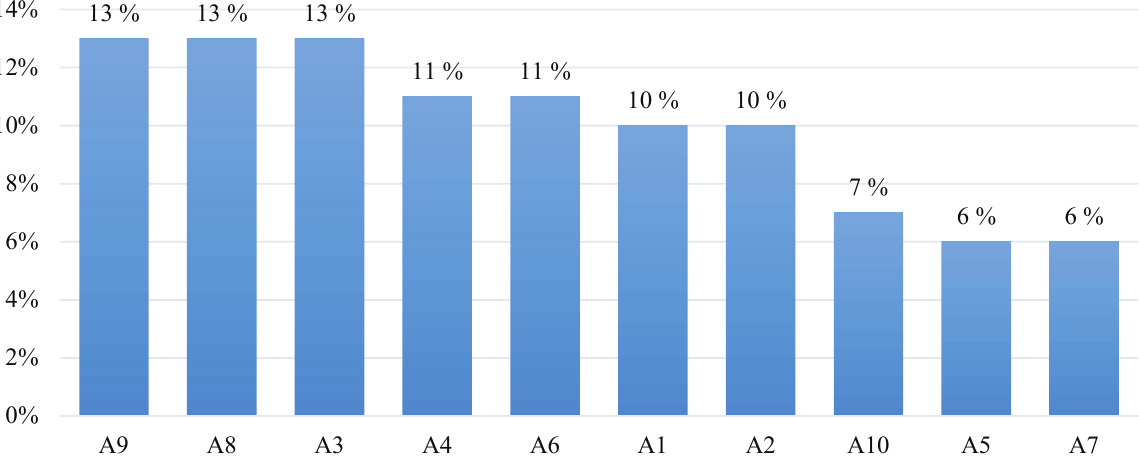
Fig. 4. Distribution of opinions of respondents about the popularity and positive attitude to NUPh: A1 – the history of HEI, A2 – the presence of traditions, A3 – state status, A4 – material and technical base (classrooms, dormitory,